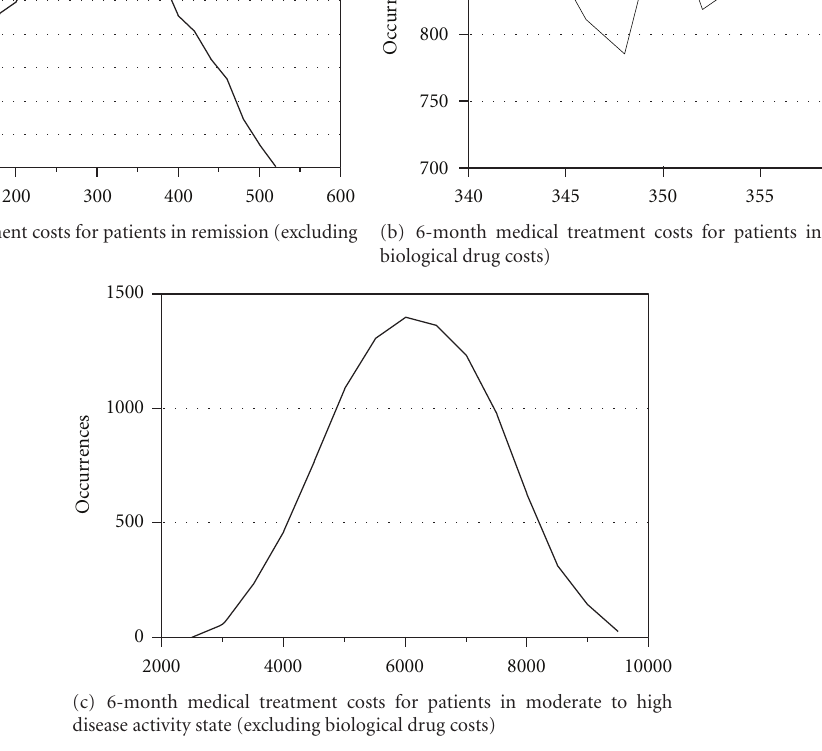
Figure 2: 6-month medical treatment costs for patients in remission (a), low disease activity state (b), and moderate to high disease activity (c), excluding biological drug costs (in Euros). Table 5: E ff ectiveness and mean cost-e ff ectiveness (MCER) for Sequences a, b, c, d over 2 years. Expected number